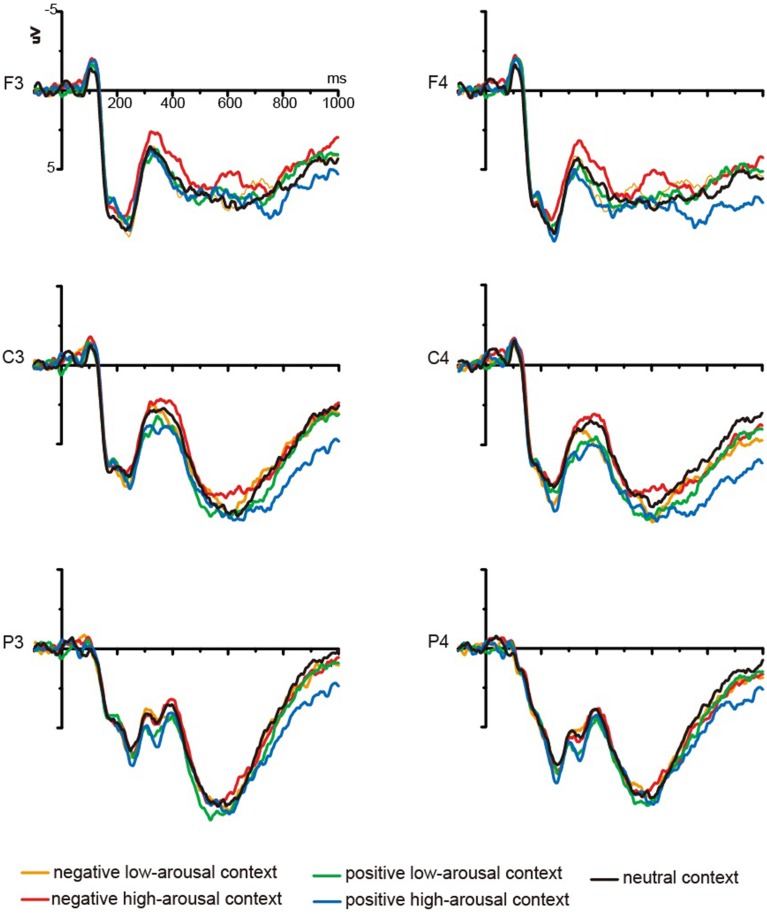
Grand mean ERPs from F3, F4, C3, C4, P3, and P4 to words encoded in five types of background pictures during recognition.